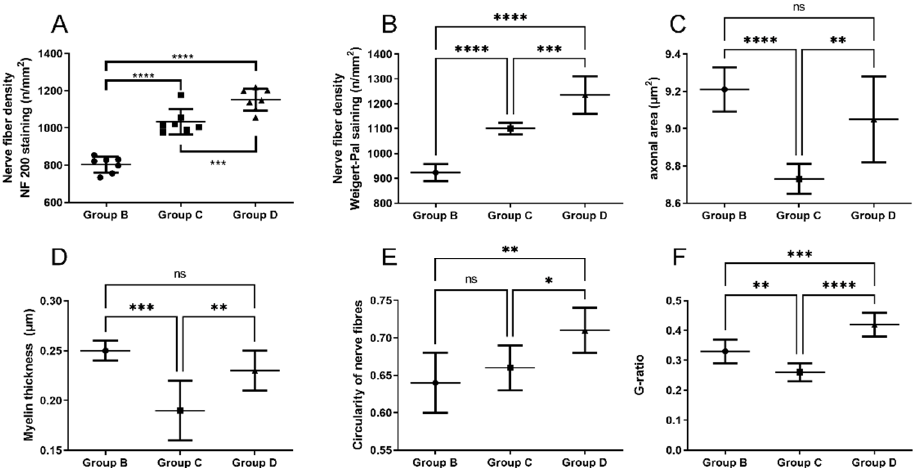
Figure 10. Nerve fibers morphometry (Group B—nerve autograft, Group C—P(LLA-CL)-COL-PANI conduit, Group D—P(LLA-CL)-COL-PANI with ASCs): ( A ) Diagram represents nerve fiber density calculated from NF200 stained images. ( B – F ) Diagrams represent nerve fiber density ( B ), axonal area ( C ), myelin thickness ( D ), nerve fiber circularity ( E ), G-ratio ( F ) calculated from Weigert-Pal stained images. Mean ± SD, * p < 0.05, ** p < 0.01 *** p < 0.001, **** p <